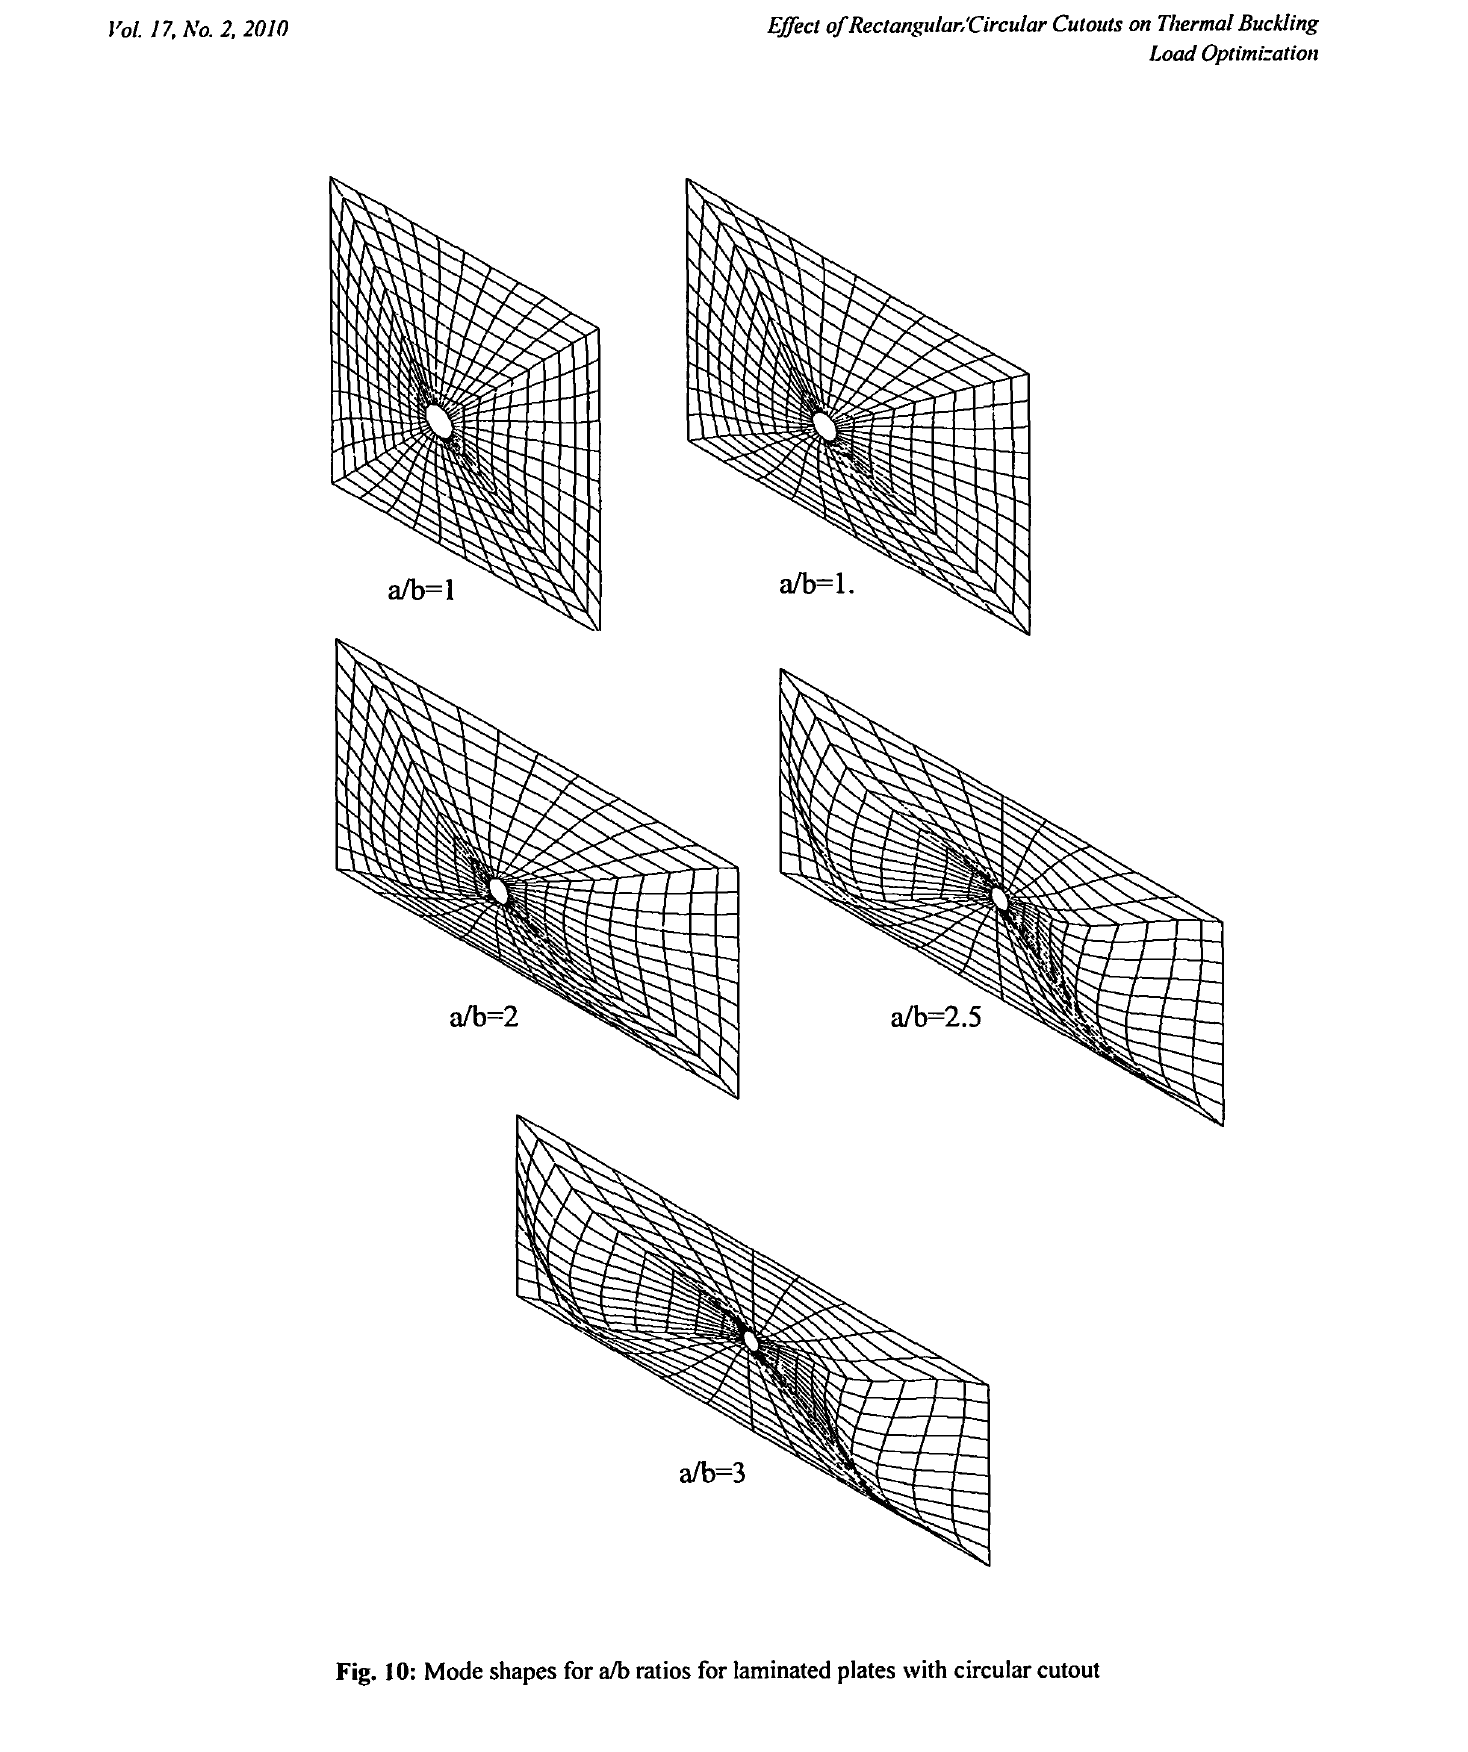
Fig. 10: Mode shapes for a/b ratios for laminated plates with circular